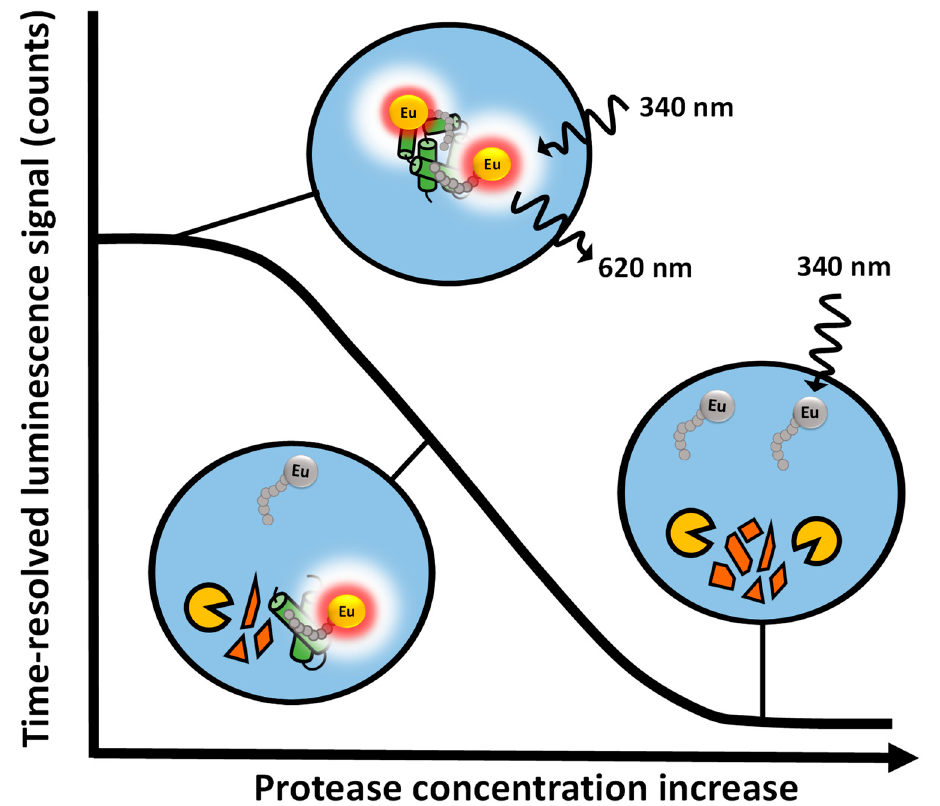
Figure 1. The principle of the protein-probe method for monitoring substrate digestion and protease activity. When no protease is present or it is inhibited, the Eu-probe can interact with the substrate protein, leading to a high TRL-signal in the modulation solution. Substrate digestion by active protease prevents the Eu-probe binding to the digested substrate. Thus the Eu-probe protection is lost, and low TRL-signal is monitored.